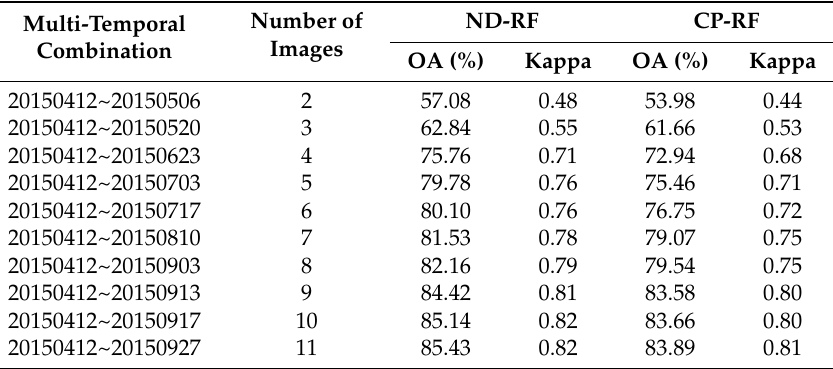
Table 8. The overall accuracy and Kappa coefficient of ND-RF and CP-RF with different combinations of multi-temporal RADARSAT-2 images after exchanging the training and testing samples in previous